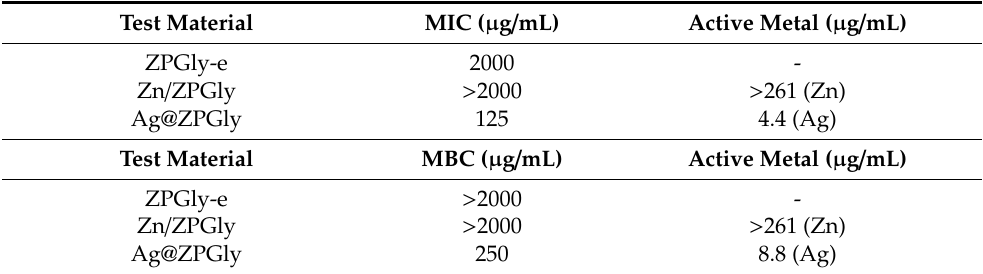
Table 2. MIC and MBC values for zirconium phosphate / phosphonate dispersions tested on E. coli ATCC ®